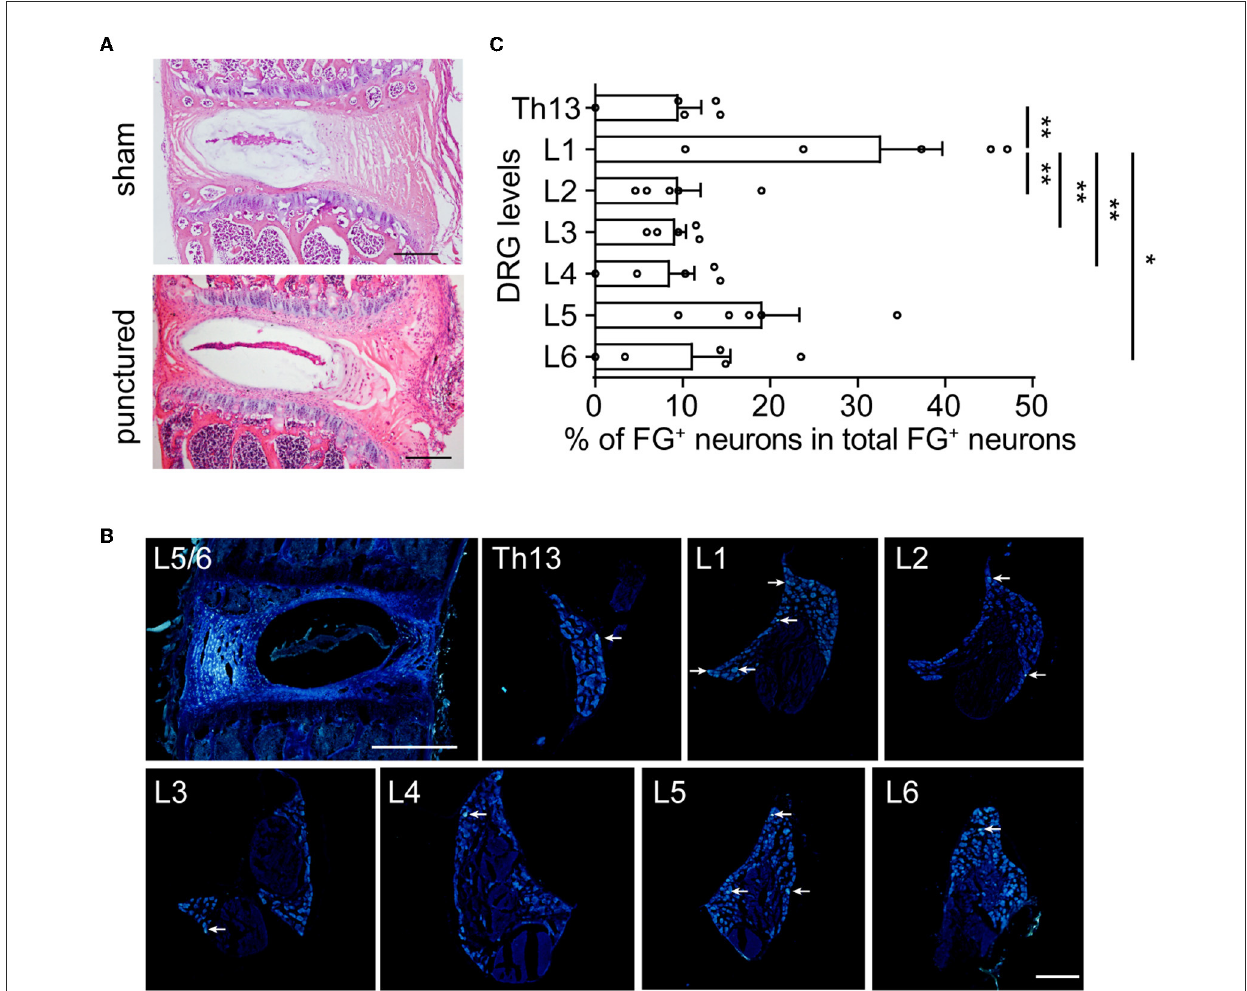
FIGURE2 In mice, the L5/6 disk was multi-segmentally innervated by Th13-L6 DRGs (mainly L1 and L5 DRGs). (A) HE staining of L5/6 disks at 10 days after sham surgery (upper) or glass needle puncture (bottom). Scale bar: 200 µ m. (B) Representative images of the disk and DRG after FG injection. Arrows indicate FG + DRG neurons. (C) The distribution of FG + DRG neurons of different spinal levels ( n = 5 mice). The percentage represents the number of FG + neurons for each level of DRG to total FG + neurons from Th13 to L6 ( n = 5 mice). Scale bars: 200 µ m for DRG and 500 µ m for disk. Values are means ± SEM. * p < 0.05 and ** p < 0.01, one-way ANOVA followed by Bonferroni’s post-hoc tests.